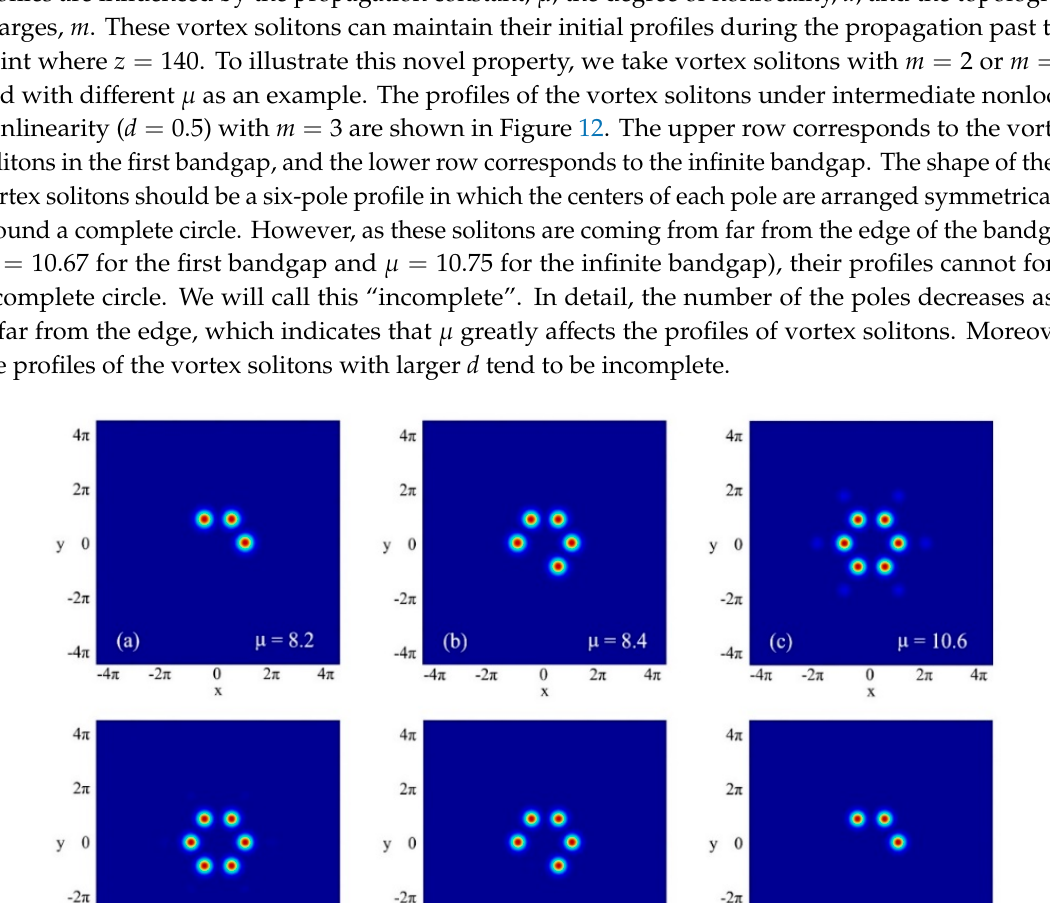
Figure 11. The phase structure evolution of vortex solitons with m = 3, d = 0.5, µ = 9. ( a – c ) correspond to the phase structures of vortex solitons with z = 0.25,1.2,2.15. The arrows point to the phases of one specific peak.